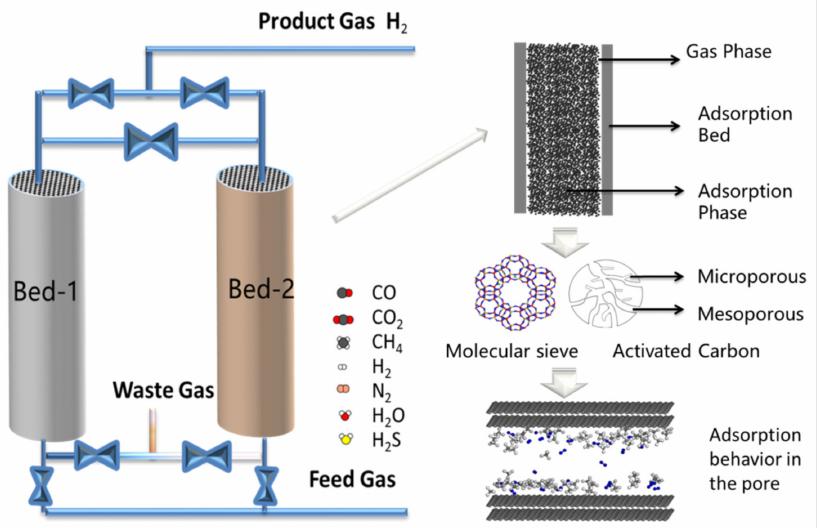
Figure 2. Flow scheme of the classical pressure swing adsorption (PSA)